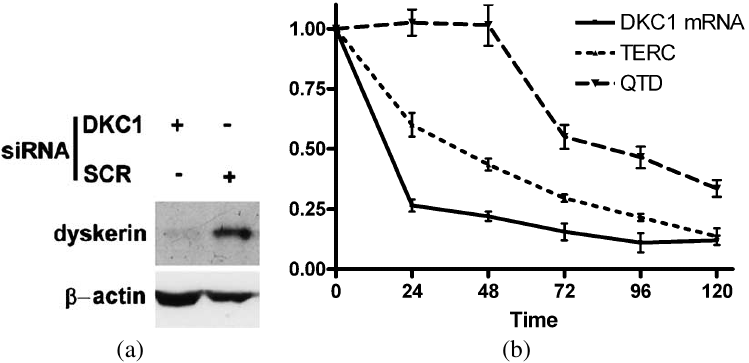
Fig. 2. Effect of DKC1 mRNA reduction by RNAi on TERC levels and telomerase activity. Twenty-four hours after transfection of DKC1 specific siRNAs a steep decrease in dyskerin levels is observed by Western blot analysis in the MCF-7 cell line (a). (b) shows a time course analysis of DKC1 mRNA levels, TERC levels by real time RT-PCR and telomerase activity by TRAP-real time assay (QTD) in the MCF-7 cell line after DKC1 specific RNAi. All measures are expressed as percentages, relative to the values of controls at each time point. Telomerase activity did not change even in the presence of a considerable reduction in TERC levels. When the TERC level was reduced below a certain threshold telomerase activity was impaired. The experiment was repeated in triplicate. Bars: standard